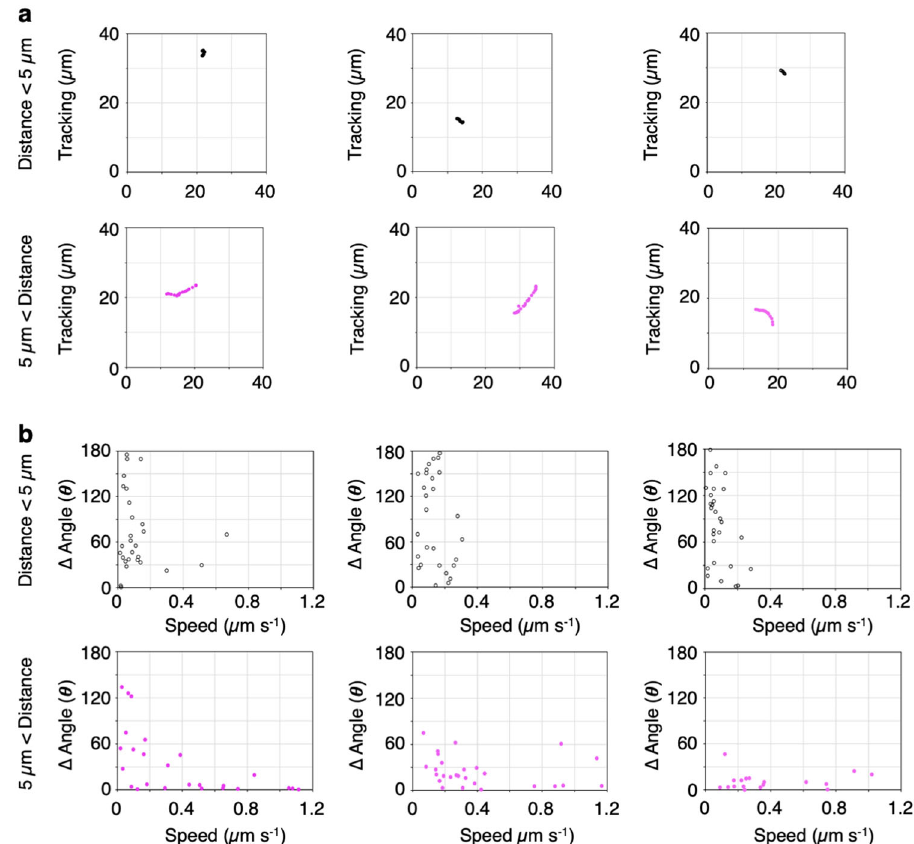
Fig. 3 Different patterns of movement between mitochondria migrating at a shorter or longer distance than 5.0 µ m. a , b Representative trajectories ( a ) and scatter plot of changes in speed and angle ( b ) of three mitochondrial movements with shorter (upper panel) or longer (lower panel) than 5.0 µ m migration distance in Fig.